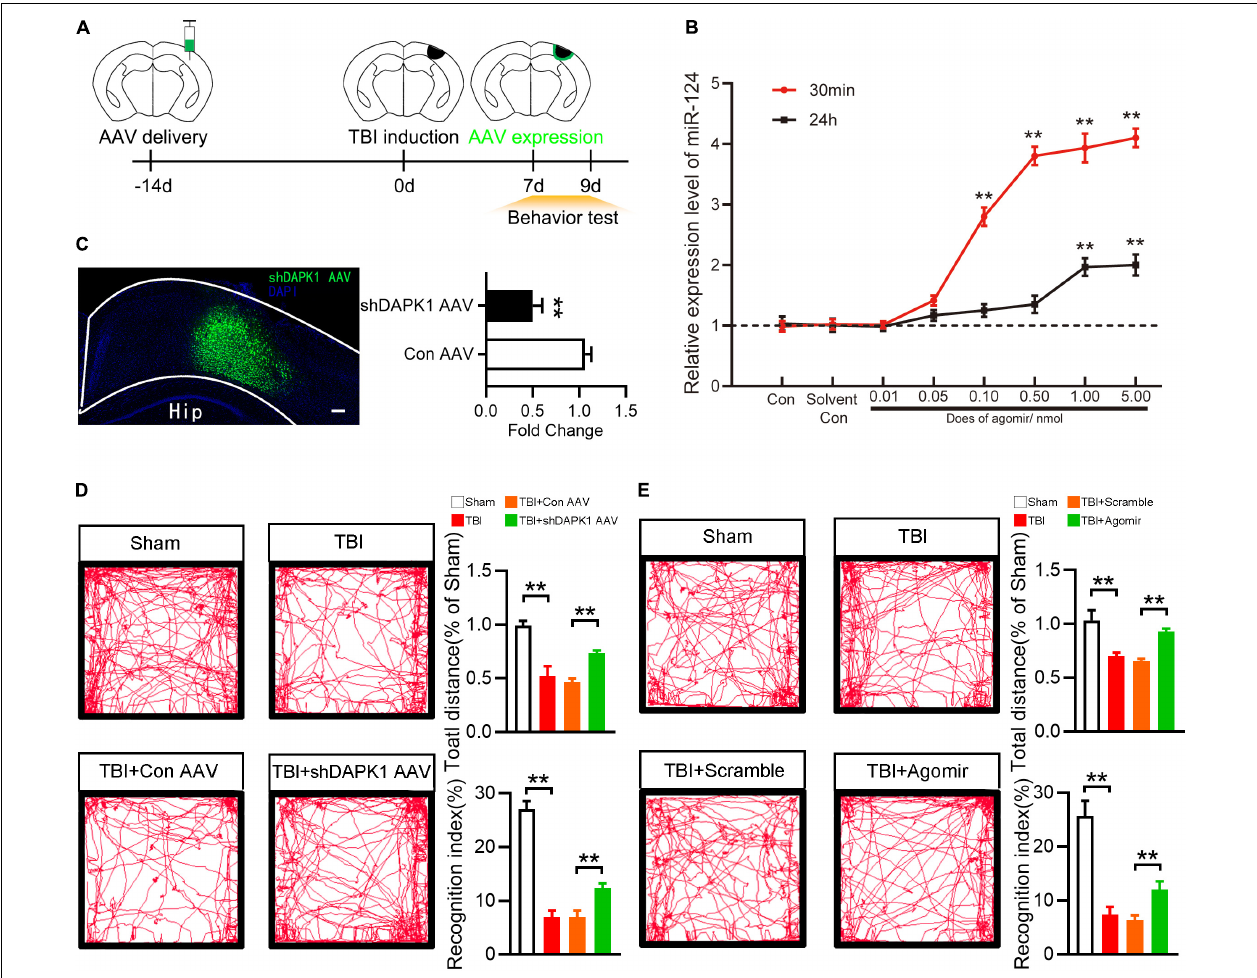
FIGURE 3 | Overexpression of miR-124 or knockdown DAPK1 rescued memory and motor change after TBI. (A) Experimental timeline of AAV injection, TBI induction and behavior tests. (B) The Expression level of miR-124 in the perilesional cortex at different time points and different dose after agomir delivery. (C) Fluorescence image represent expression of AAV-shDAPK1 in the cortex, and quantitative analysis of the expression level of DAPK1 after AAV-shDAPK1 or AAV-Con injection. Scale bar, 100 µ m. (D) Representative open field activity tracks and statistical analysis of total distance traveled and recognition index after AAV-shDAPK1 or AAV-Con injection. (E) The representative open field activity tracks and statistical analysis of total distance traveled and recognition index after agomir or scramble injection. n = 6 for each group; ** p < 0.01; Values are presented as the mean ±